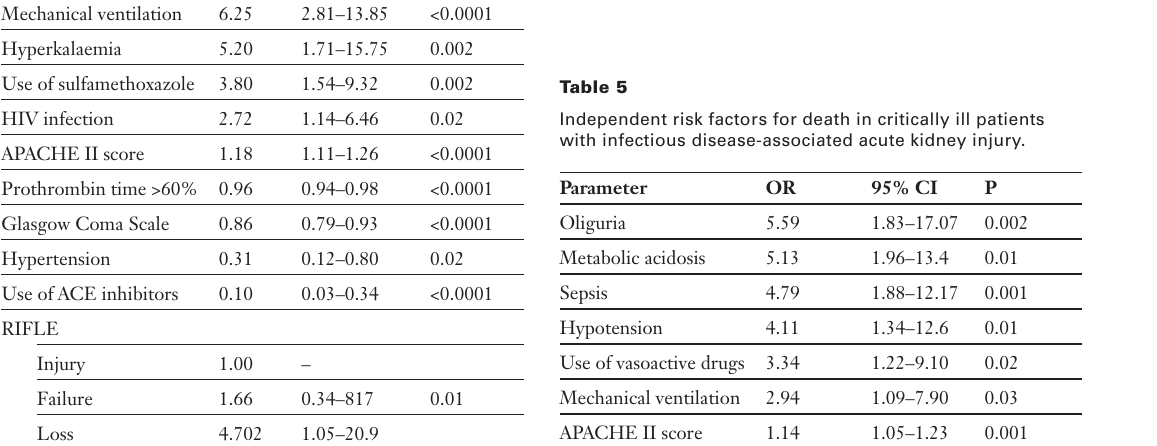
Univariate analysis for risk factors for death in critically ill patients with infec- tious disease-associ- ated acute kidney in- jury.